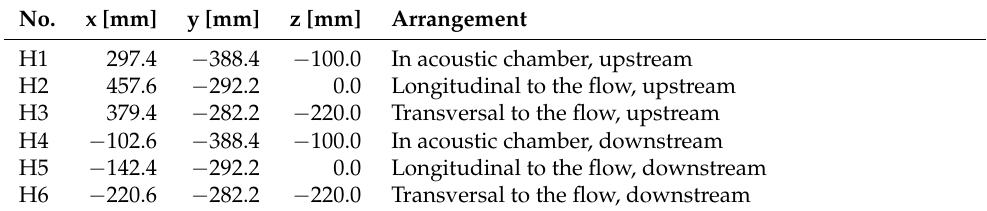
Figure 5. Sketch of the hydrophone placement inside the cavitation tunnel and the common frame of reference. Table 2. Hydrophone coordinates and arrangement description in the cavitation